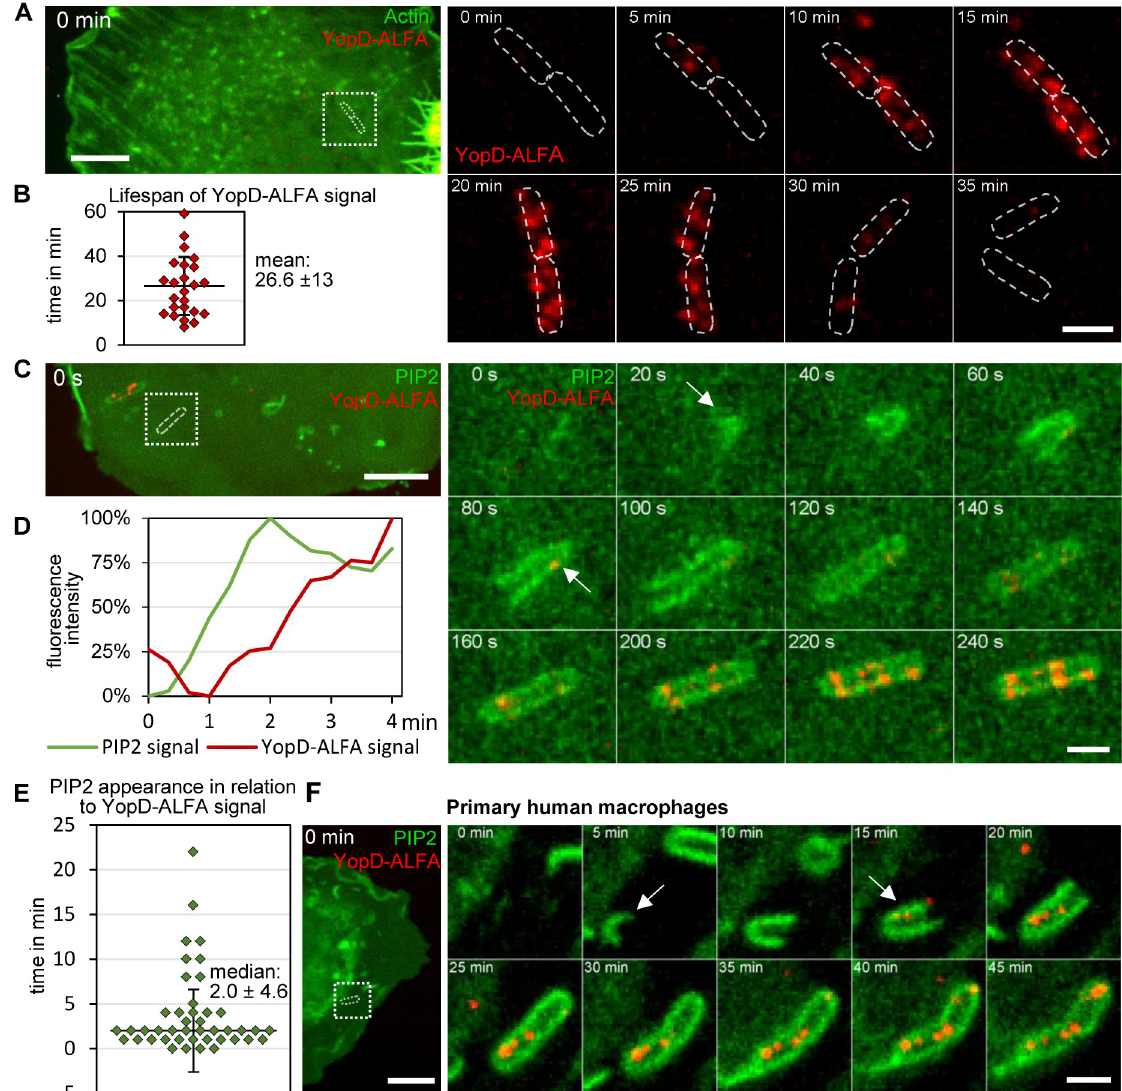
Fig 3. Nanobody-based live imaging of translocons: Formation and lifespan of the translocon during cell infection. (A) Live imaging of translocons during HeLa cell infection. HeLa cells expressing myc-Rac1Q61L and GFP-LifeAct were infected with WA-314 YopD-ALFA at an MOI of 20 and incubated with NbALFA-580 diluted in the cell culture medium. Cells were imaged with a spinning disk microscope recording z-stacks every minute. Stacks for each time point were combined to one image using maximum intensity projection and one image every 5 min is shown. The left panel shows the overview image at 0 min. The boxed region in the overview image shows the area of the video depicted in still frames to the right. Dashed white lines indicate the outline of the bacteria. Scale bars: 10 μ m (overview) and 2 μ m (still frames). (B) Lifespan of the translocon. The lifespan of the translocons was determined using movies that recorded the YopD- signal of individual bacteria from their formation to disappearance. Experimental conditions are as in (A). n = 25 bacteria (7 independent experiments, 13 host cells) (C) Engulfment in PIP2-positive membranes precedes translocon formation in HeLa cells. HeLa cells expressing myc-Rac1Q61L and PLC δ 1-PH-GFP were infected with WA-314 YopD-ALFA at an MOI of 20 and incubated with NbALFA- 580 diluted in cell culture medium. Cells were imaged with a spinning disk microscope recording z-stacks every 20 s. Stacks for each time point were combined to one image using maximum intensity projection and one image every 20 s is shown. The left panel shows the overview image at 0 min. The boxed region in the overview image shows the area of the video depicted in still frames to the right. White arrows indicate the appearance of PLC δ 1-PH-GFP and the first translocon signal. Scale bar: 10 μ m (overview) and 2 μ m (still frames). (D) Fluorescence intensities of PIP2 marker PLC δ 1-PH-GFP and YopD-ALFA signals. The relative fluorescence intensities of PLC δ 1-PH-GFP and NbALFA-580 signals at the bacteria in (C) were plotted to illustrate the temporal relationship of signal appearances. (E) Temporal relationship of engulfment in PIP2-positive membranes and appearance of YopD-ALFA signal. The time intervals between first occurrence of the PLC δ 1-PH-GFP and first YopD-ALFA signals were measured based on live imaging experiments performed as in (C). Each dot represents one measurement. n = 43 bacteria (3 independent experiments, 13 movies). (F) Engulfment in PIP2-positive membranes precedes translocon formation in primary human macrophages. Primary human macrophages expressing PLC δ 1-PH-GFP